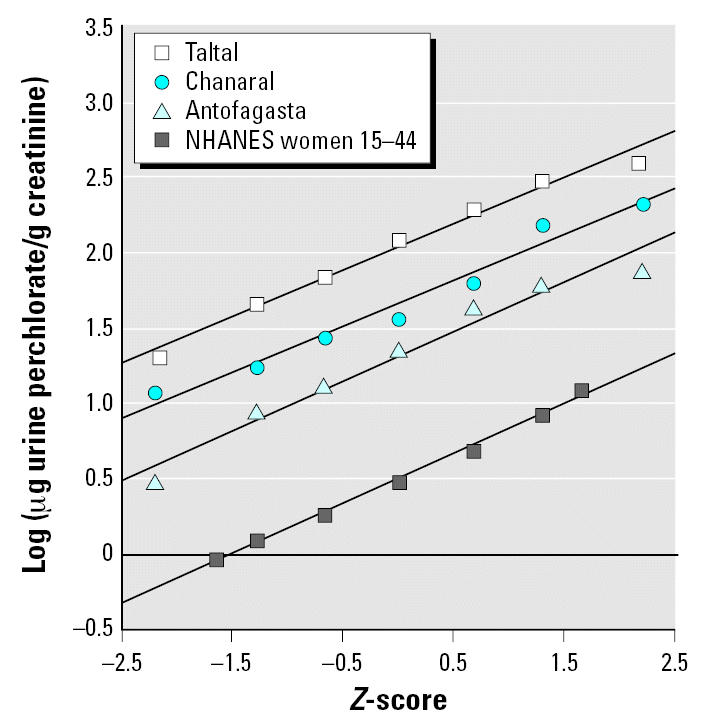
Log-normal probability plots of the distributions of urinary perchlorate excretion in three Chilean cities and the United States. Taltal: y = 2.03 + 0.306x; R2 = 0.984. Chanaral: y = 1.66 + 0.304x; R2 = 0.968. Antofagasta: y = 1.31 + 0.326x; R2 = 0.962. NHANES: y =0.50 + 0.332x; R2 = 0.997.